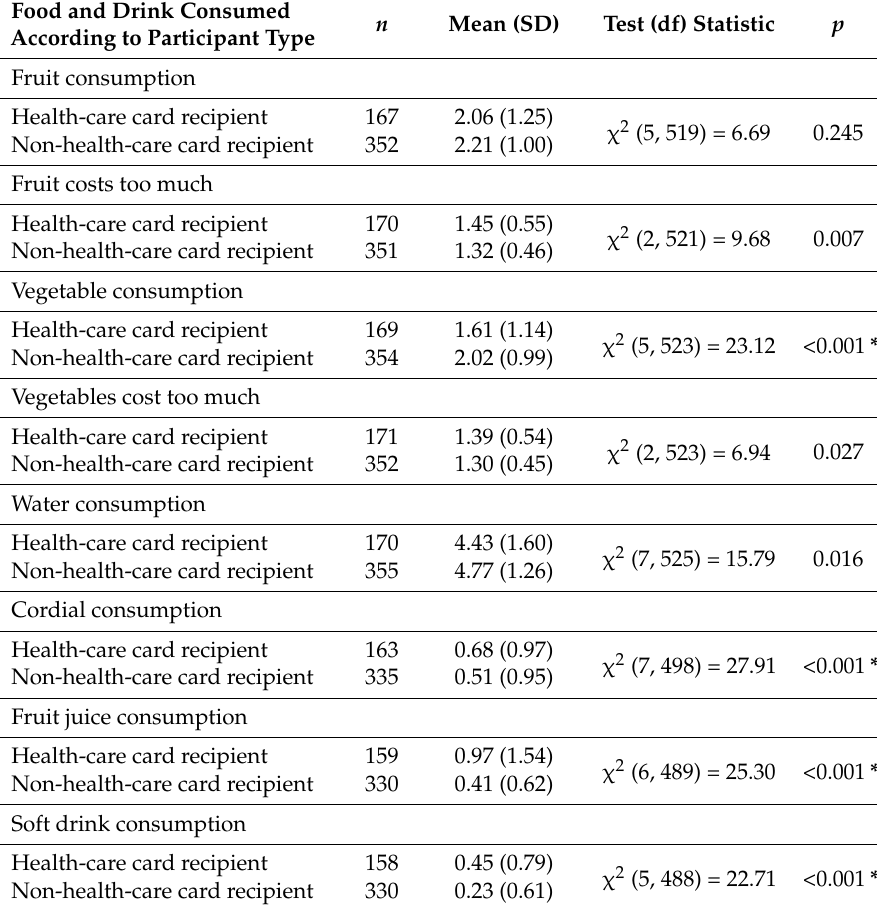
Table 4. Differences in food consumption of health-care and non-health-care card